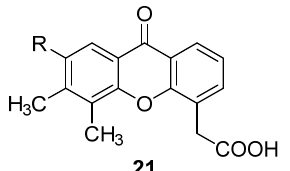
Figure 16. 7-Substituted DMXAA analogues.